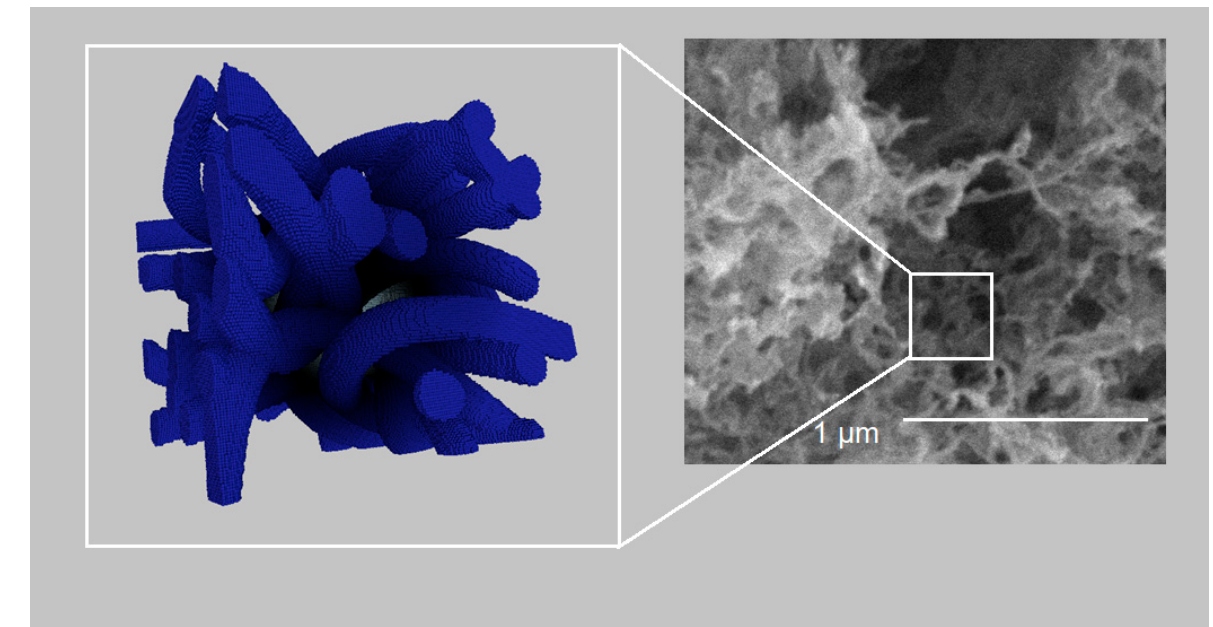
Figure 17. Visual comparison between three-dimensional digital copy and SEM image of sample 2.